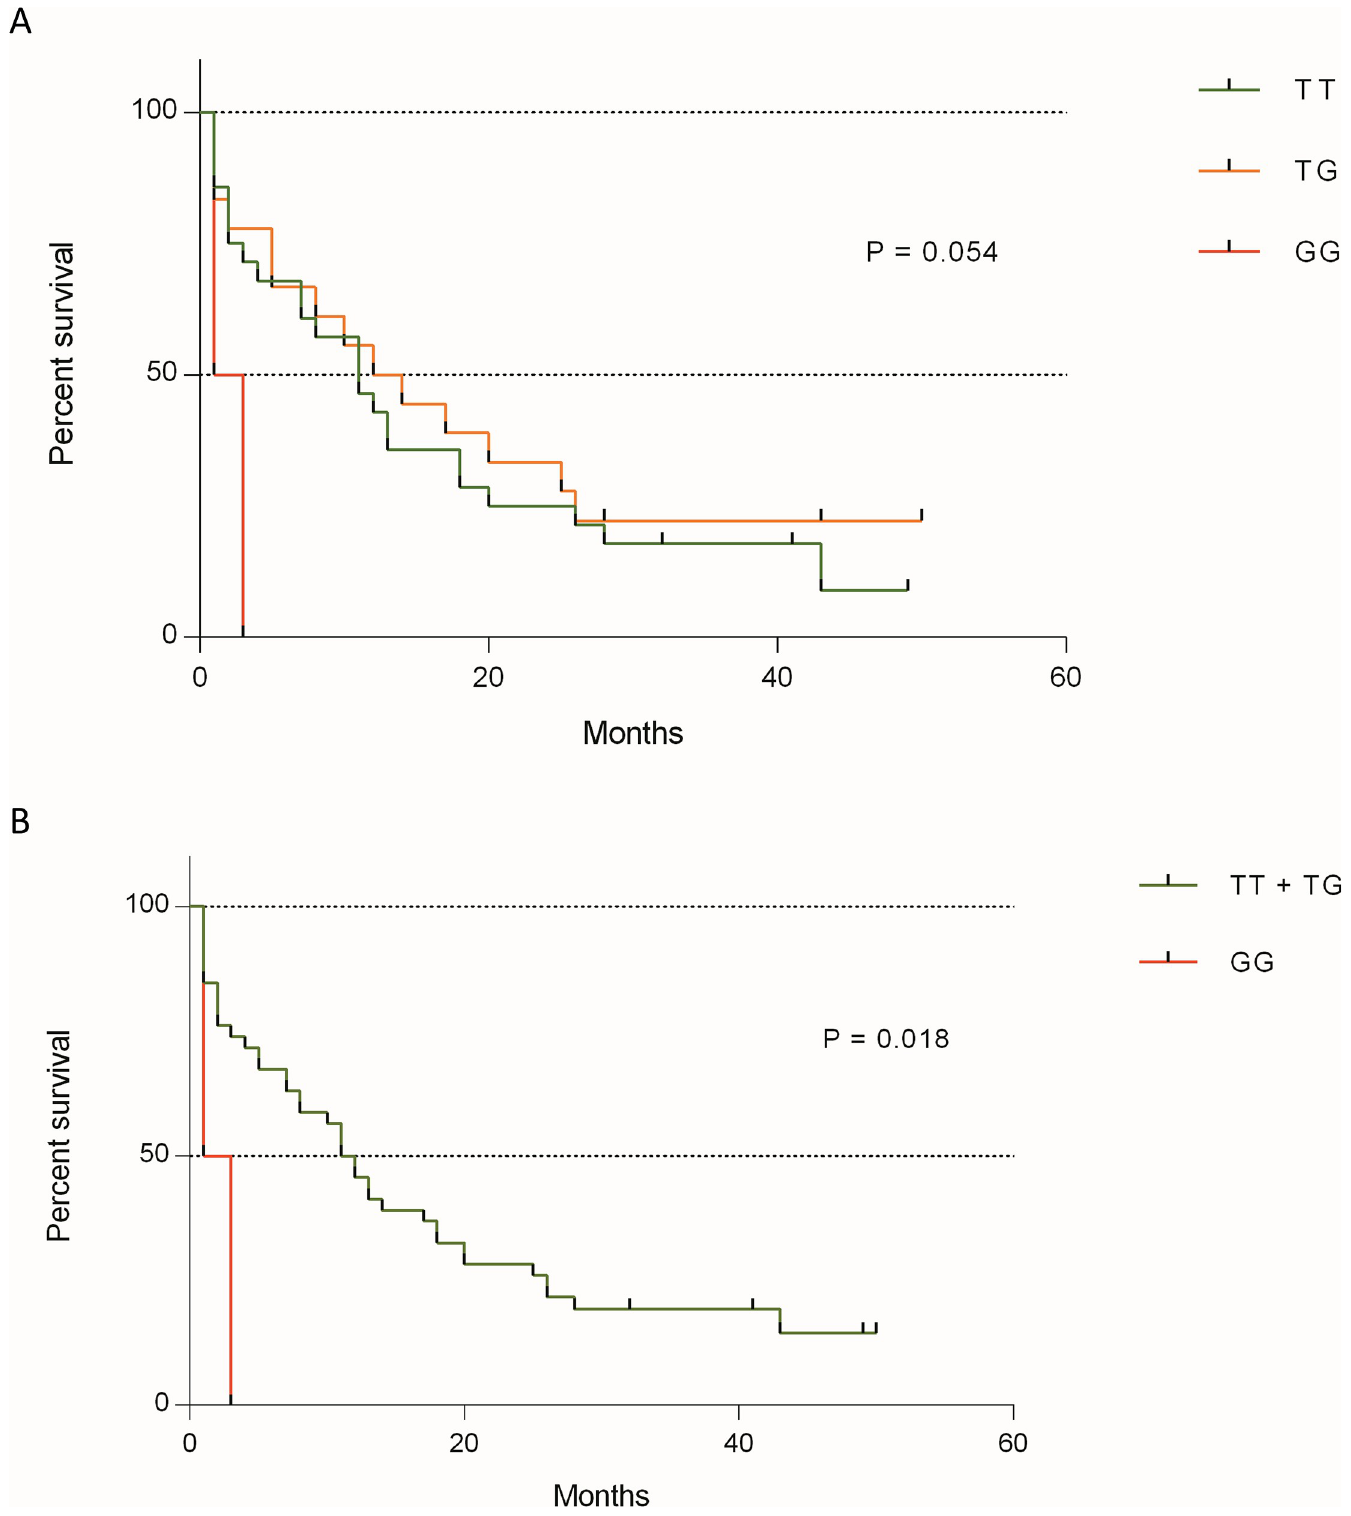
Fig 1. Kaplan-Meier survival estimates. (A) Survival analysis of the AGT rs5050 genotypes (TT in green, TG in orange, and GG in red) separately, showing the shorter survival in GG-genotype patients (p = .05). (B) Comparing GG-genotype against TT + TG-genotypes of AGT rs5050, patients harboring GG-genotype (in red) exhibited lower survival rates compared to TT + TG (in green) genotypes patients (2 vs. 11.5 months [p = .01]).